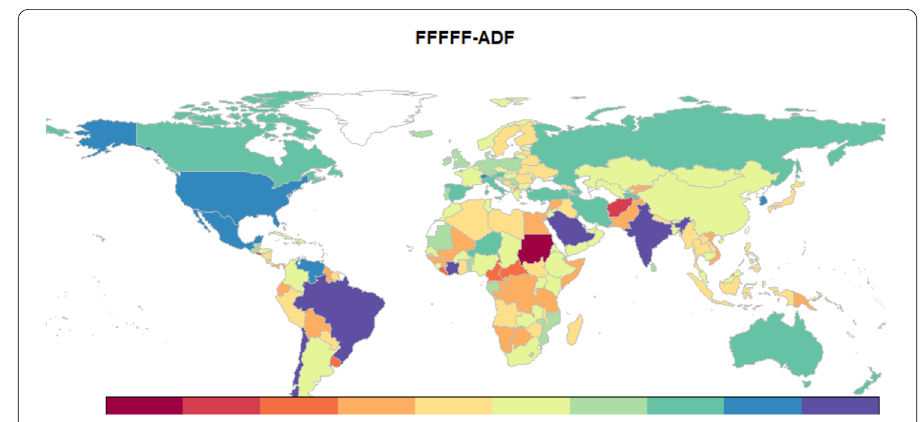
Figure 8 FFFFF-ADF test results with significance level tabulated on the World map